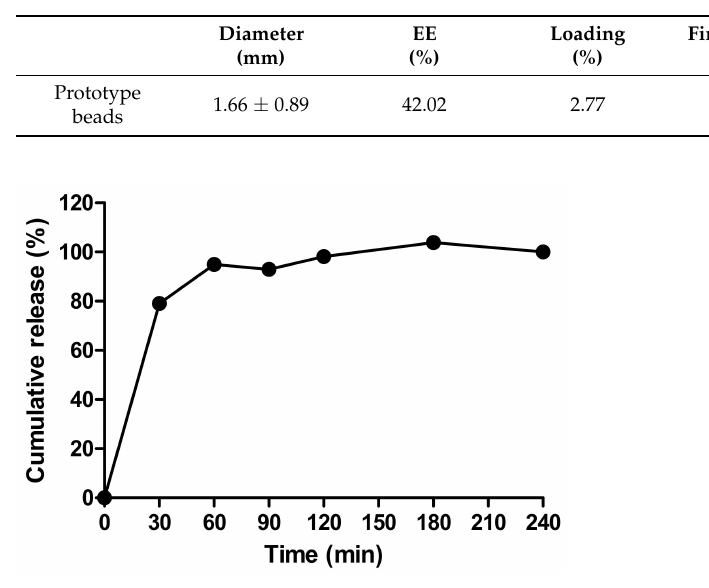
Figure 6. ( A ) Encapsulator-generated, lyophilised insulin-dWPI beads; ( B ) the same beads packed inside a funnel for the in vivo rat jejunal instillation study. Table 4. Characterisation of insulin-dWPI beads synthesised by the Buchi encapsulator. For diameter, the data are presented as mean ± SD across 73 individual bead measurements.